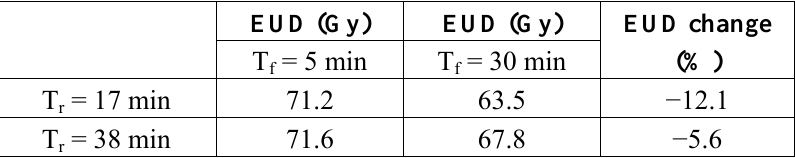
Table 1. Comparison of EUD changes assuming different fraction dose delivery time (same DVHs were used). The derived results from this analysis: α / β = 8.3 ± 4.1 Gy, = 17 ± 21 min and T = 4.0 ± 1.8 day were used in the α = 0.22 ± 0.08 Gy − 1 , T r d EUD calculation.